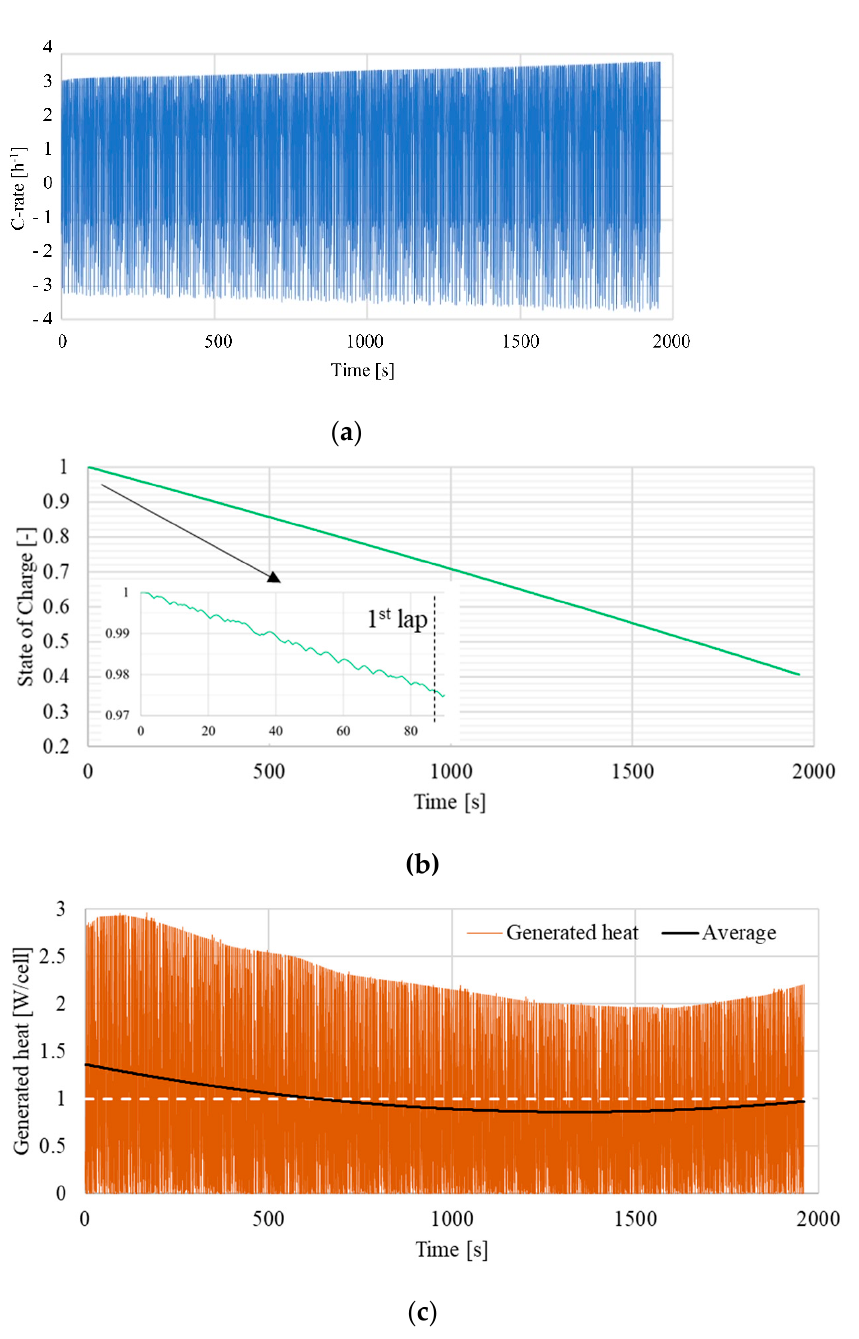
Figure 4. Battery working parameters: ( a ) C-rate; ( b ) state of charge; ( c ) generated heat.